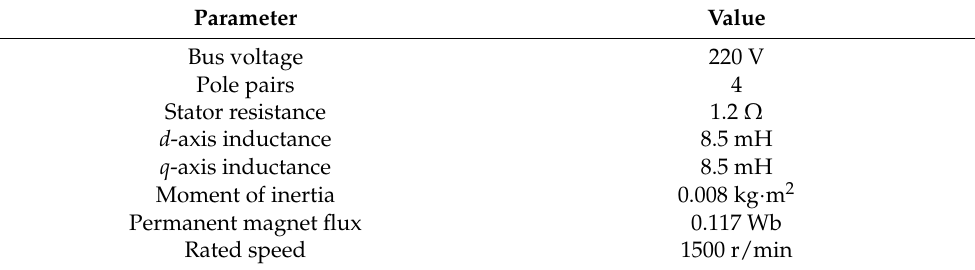
Table 2. Parameters of PMSM.